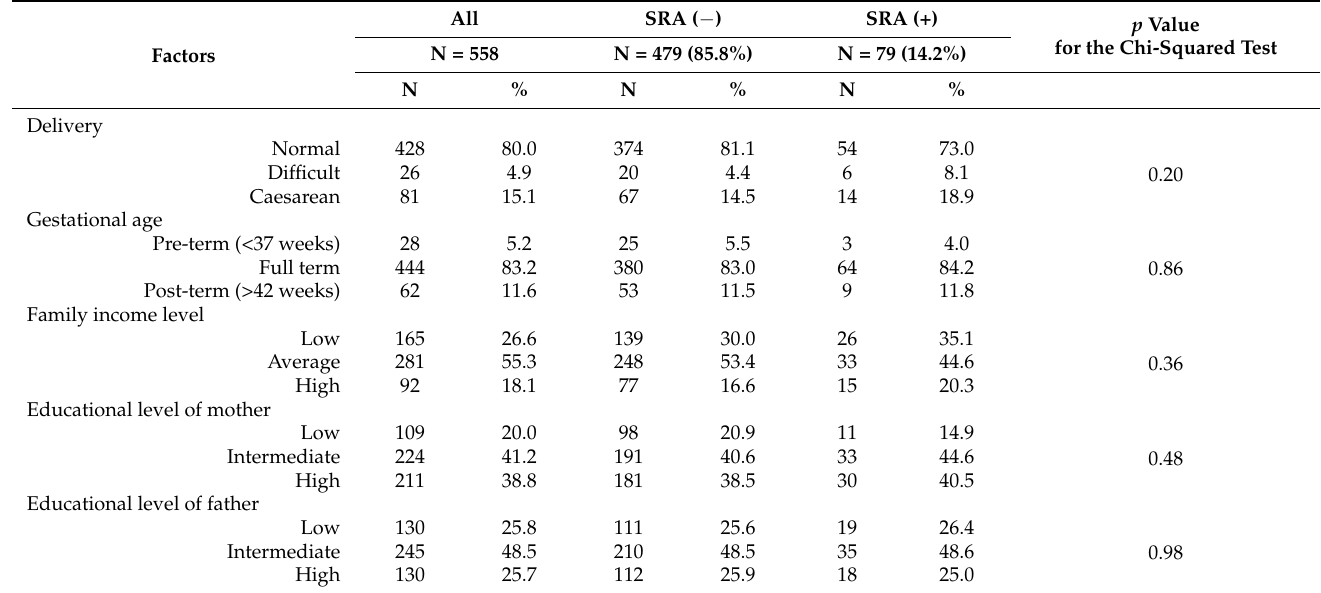
Abbreviations: short root anomaly, SRA. Table 3. Characteristics of participants based on the presence of